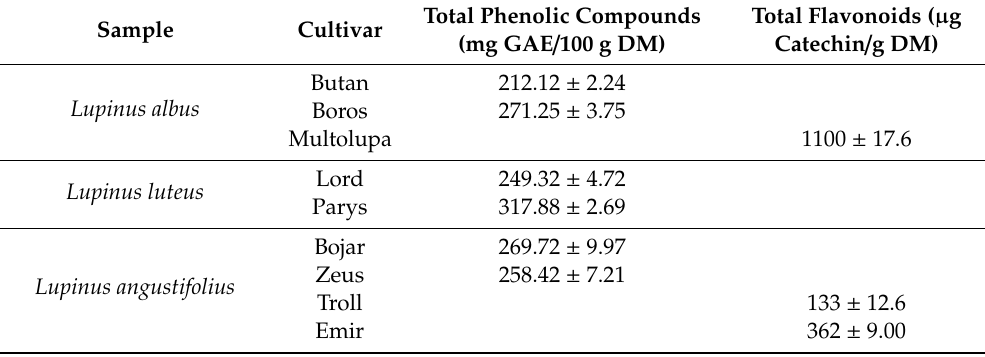
Table 5. The content of total phenolic compounds (gallic acid equivalent) and flavonoids (catechin equivalent) from seeds of lupine